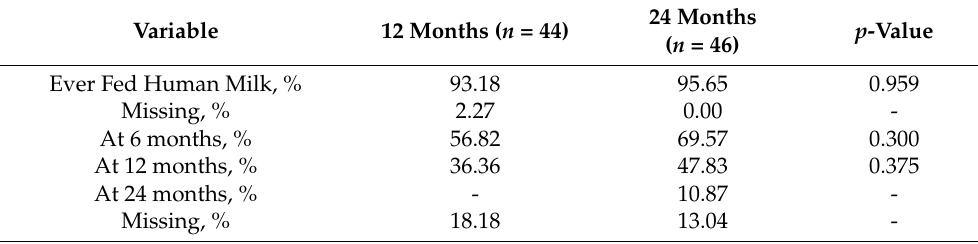
Table 2. Breastfeeding trends by child